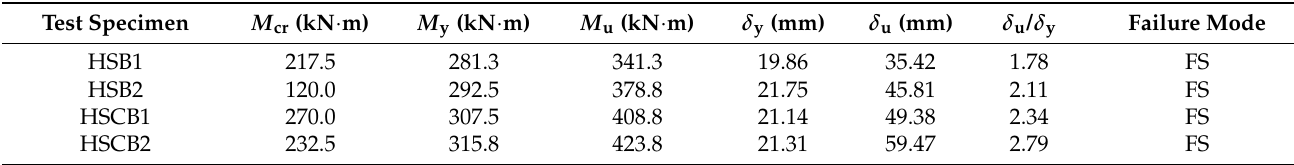
Table 3. Bending test results of composite beams.